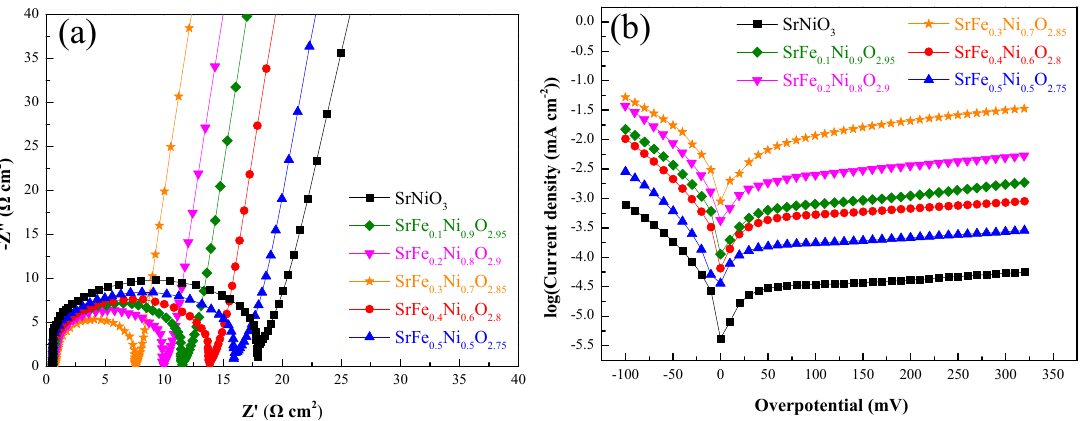
Figure 14. Electrochemical Impedance Spectroscopy (EIS) ( a ) and Tafel curves ( b ) of SrFe x Ni 1 − x O 3 − δ . Table 5. Parameters of SrFe x Ni 1 − x O 3 − δ